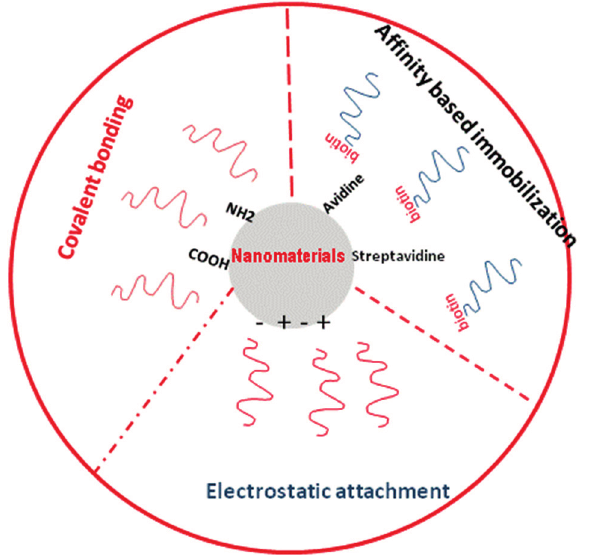
Figure 2. Nanomaterial-based immobilization